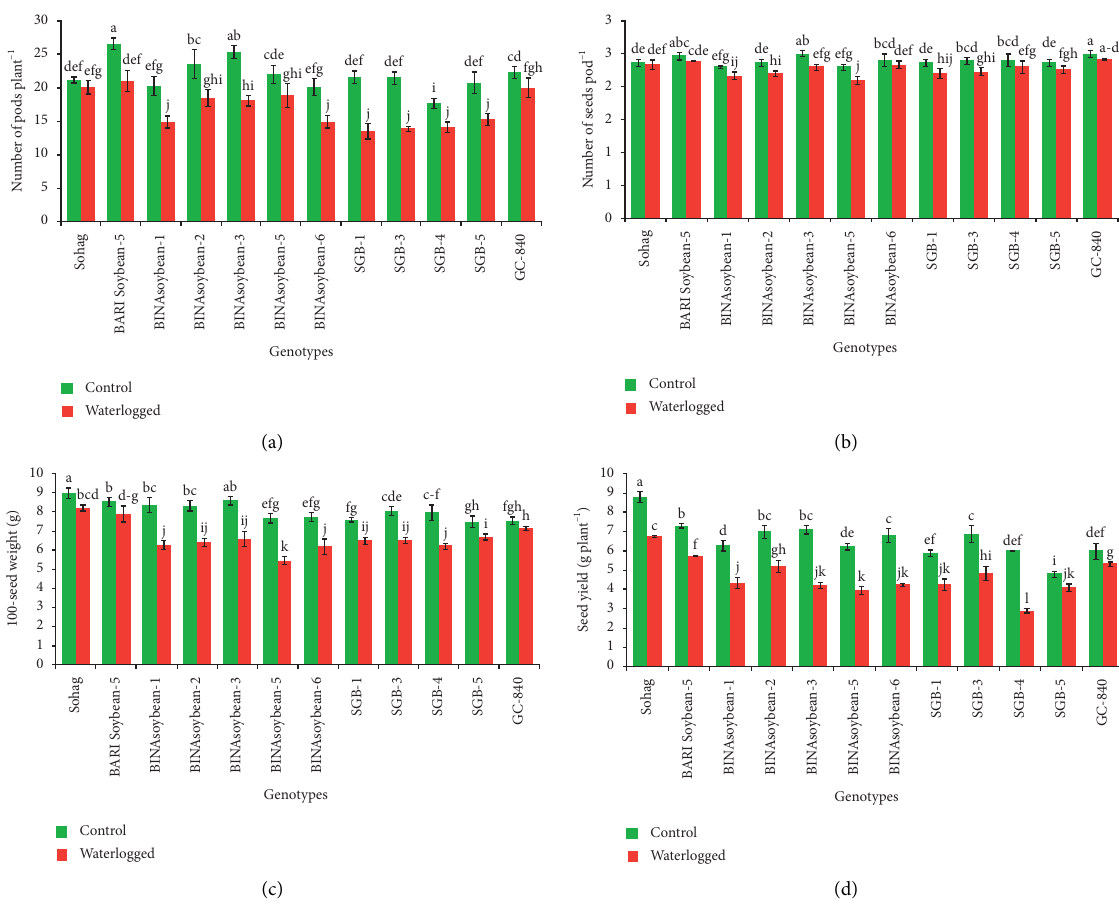
Figure 9: Effect of waterlogging stress on the number of pods plant − 1 (a), number of seeds pod − 1 (b), 100-seed weight, (c) and seed yield plant − 1 (d) of different soybean genotypes. For each treatment, the mean ( ± SD) was determined from three replicates. Different alphabets on the bars indicate significant difference at P ≤ 0 . 05 after mean comparison by Fisher’s LSD